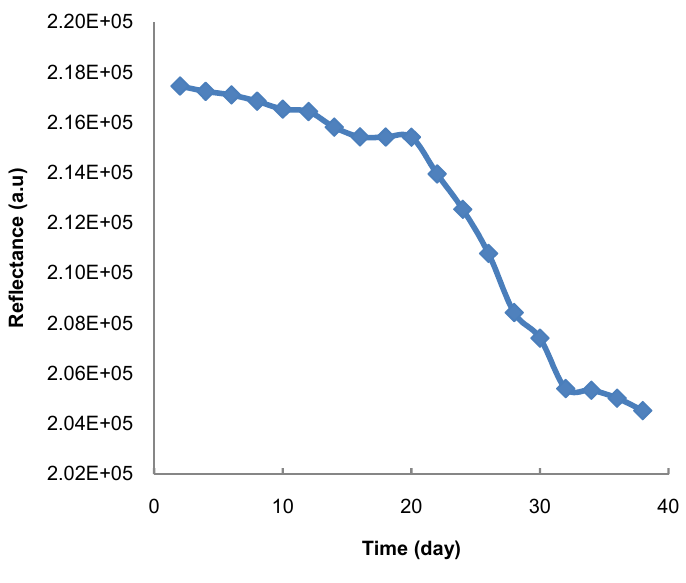
Figure 7. The stability of the developed test strip.